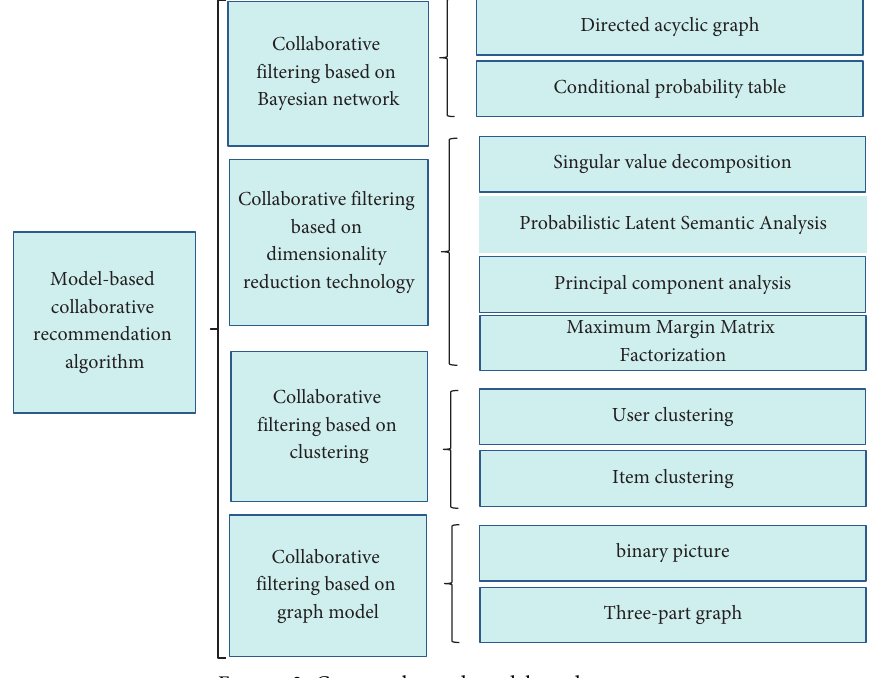
Figure 3: Commonly used models and